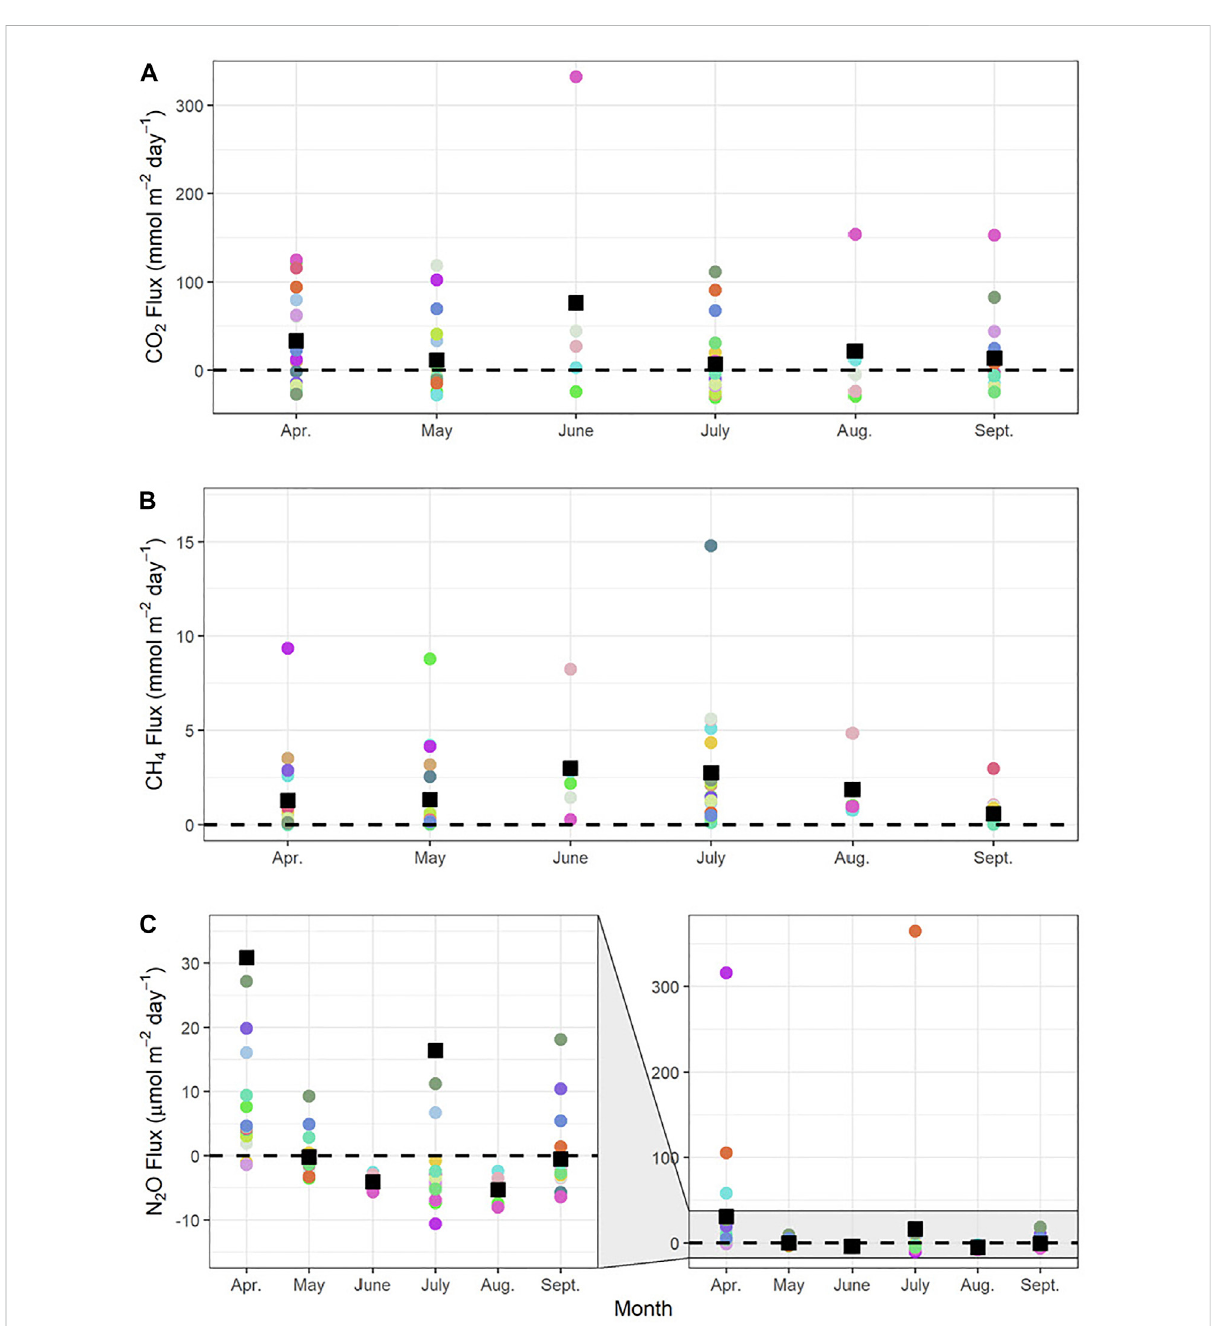
FIGURE 2 (A) Carbon Dioxide (CO 2 ) (B) methane (CH 4 ), and (C) nitrous oxide (N 2 O) fl ux for the sampling period. Each coloured circle represents a single reservoir,whiletheblacksquarerepresentsthemonthlymean.Blackdashedlineatmosphericequilibrium,wherevaluesaboveindicatelossofgasto theatmosphereandvaluesbelowindicateremovalofgasfromtheatmosphere.OneoutlyingCH 4 valueinAprilwasomitted(value=100 mmolm-2 day-1) as it is assumed that an ebullition event was